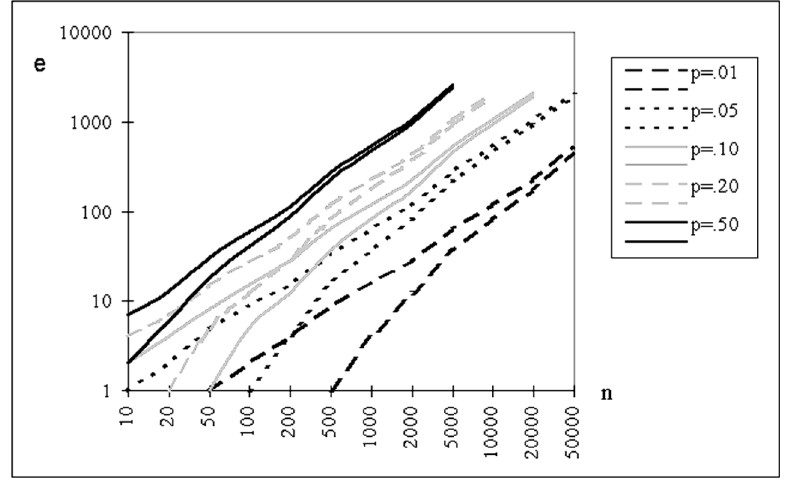
Fig. 8. 95% confidence regions of the same probability of occurrence p for e events in increasing numbers of n events. Each pair of graphs indicate, how in n trials an event occurs with the probability of occurrence p between the lower and upper range (compare with Table 4).